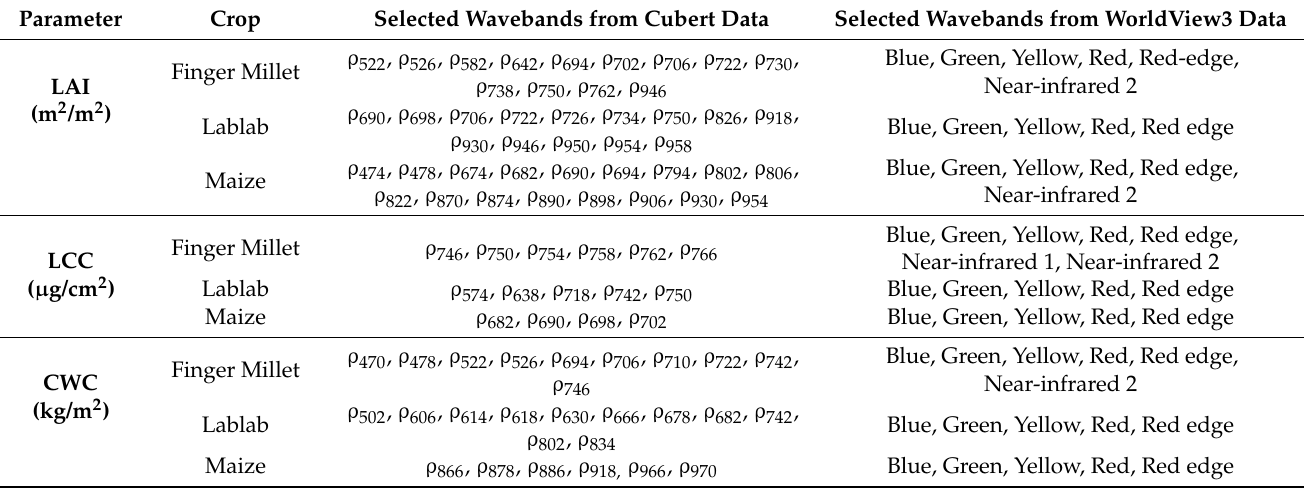
Table 5. Selected wavebands from Boruta feature selection algorithms for each crop vegetation parameter (LAI: leaf area index, LCC: leaf chlorophyll content, CWC: canopy water content) from two remote sensing datasets. Cubert bands are indicated as the band wavelength ( ρ xxx ) in